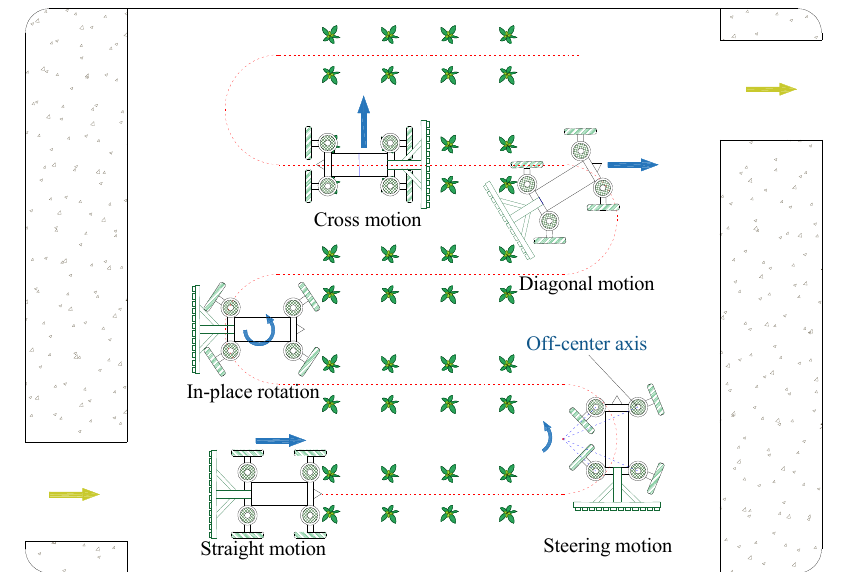
Figure 1. Diagram of the motion modes for the robot chassis. Notes: